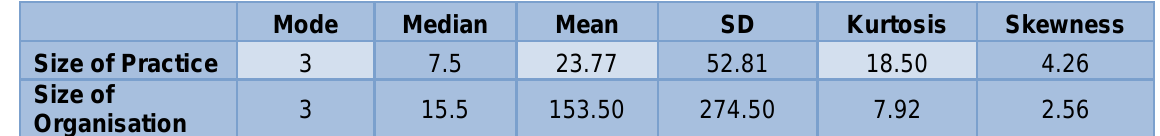
Table 5 Modes, medians, means and standard deviations for size of practice (n = 84) and total size of organisation (n = 74)